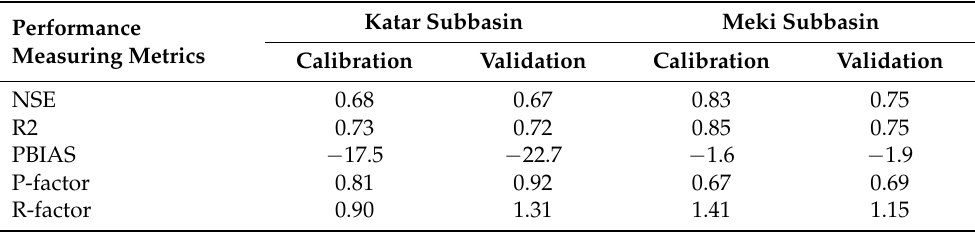
Figure 6. Monthly correlation of observed and simulated flow during calibration and validation of Katar and Meki subbasins. 3.5. Hydrology of Katar and Meki Subbasins The hydrology of the Katar and Meki subbasins can be investigated after running a SWAT error check for 1999 to 2014 for both subbasins and after determining the ratio of the water balance component summarized in Table 6. As a result, the ratio of precipitation to stream flow was 0.3 and the base flow to total flow was 0.49 for the Katar subbasin. This indicated that 51% of the runoff flow and base flow had a contribution of 49% of the total